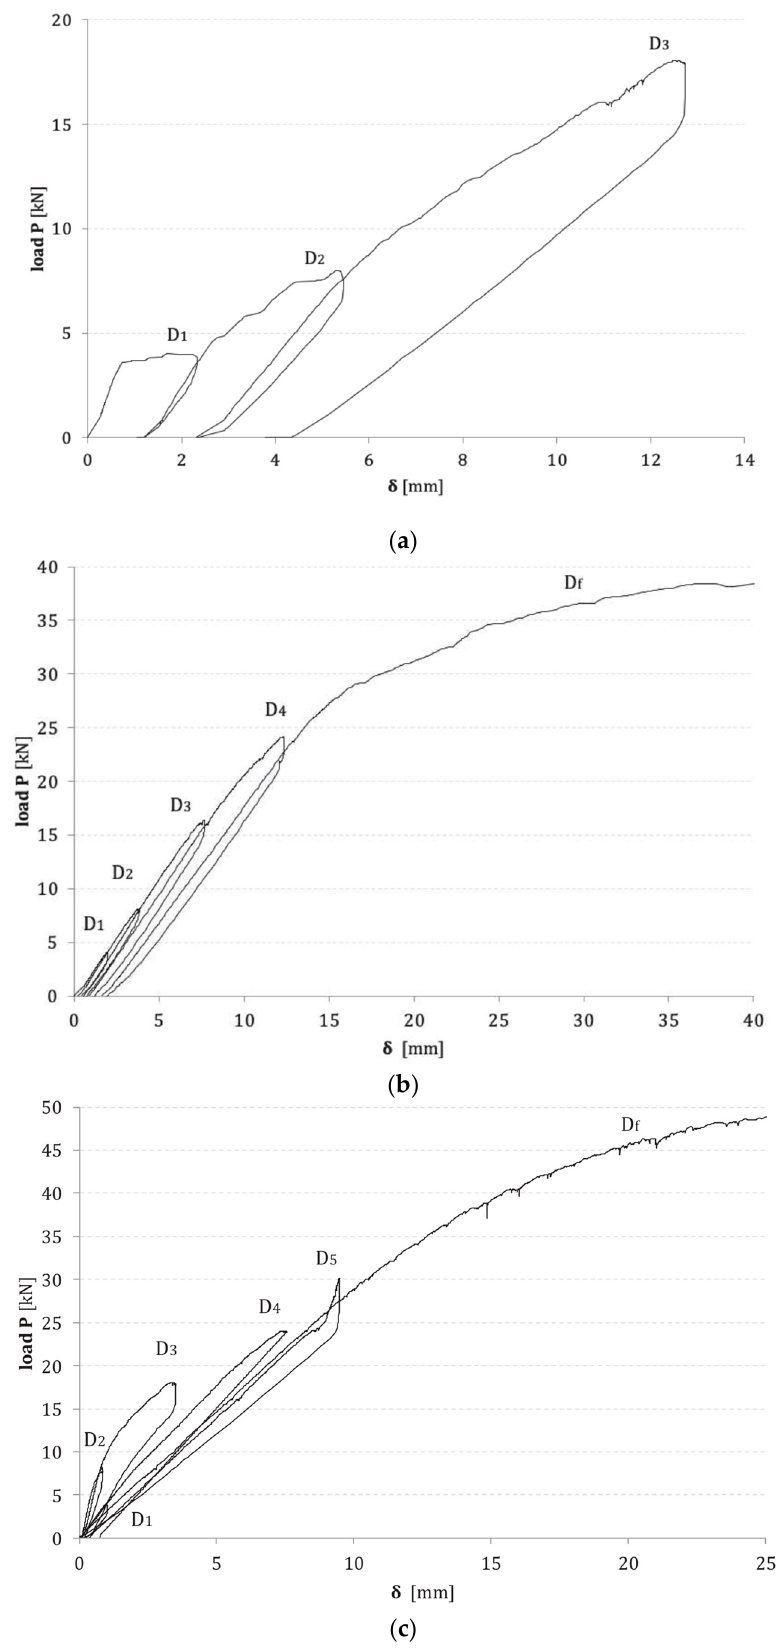
Figure 7. Experimental diagram load, P , vs. deflection, δ , at midspan of tested RC beams without and with strengthening. ( a ) B1; ( b ) B1 GFRP ; ( c ) B2 CFRP .